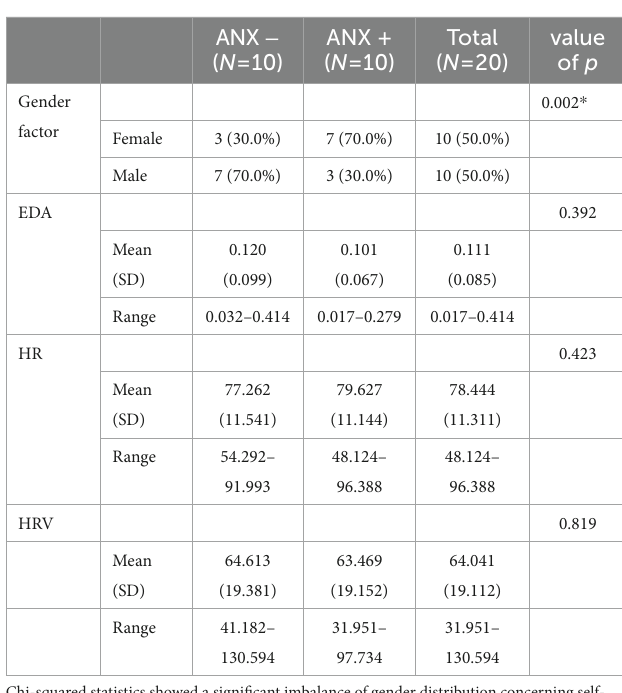
TABLE 2 Gender factor and EDA, HRV, HR values in ANX − and ANX+